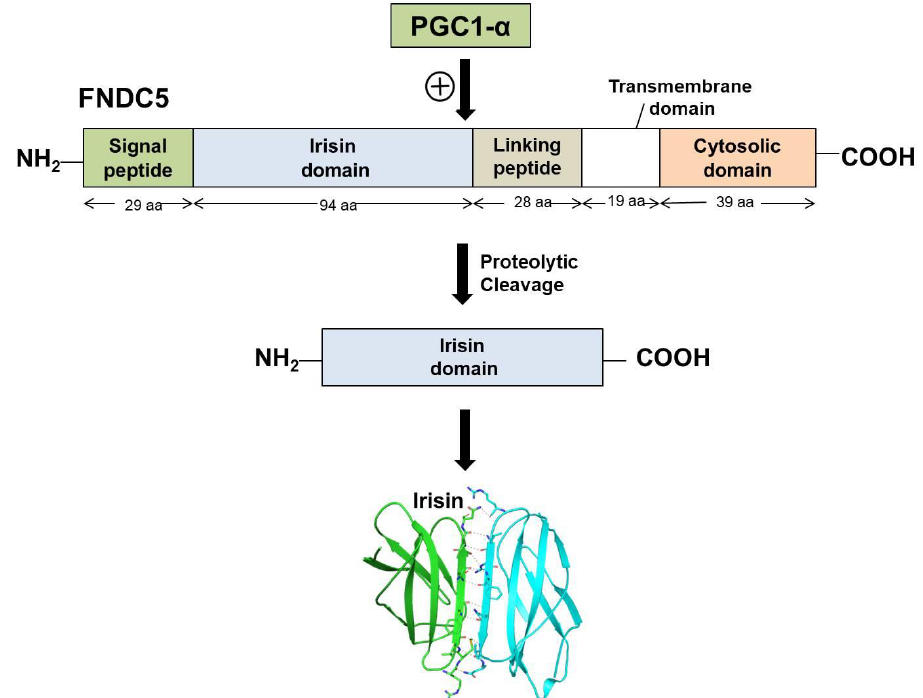
Figure 1. Schematic representation of FNDC5 structure and formation of